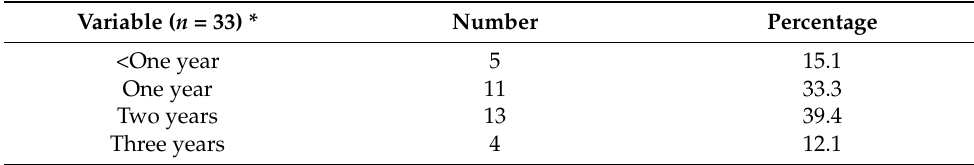
Table 6. The timescales of the partnerships